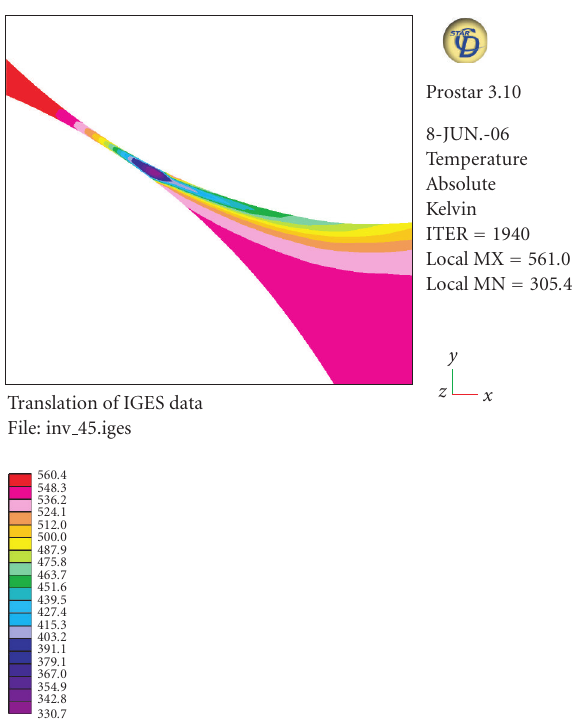
Figure 11: Static temperature contours in rotor-rotor